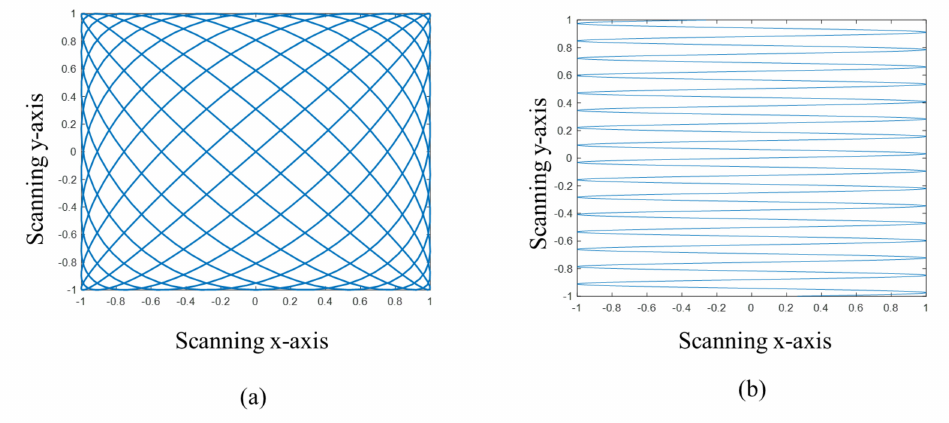
Figure 2. Examples of scanning method. ( a , b ) Examples of optical path utilizing Lissajous pattern, in which both axes have a resonance